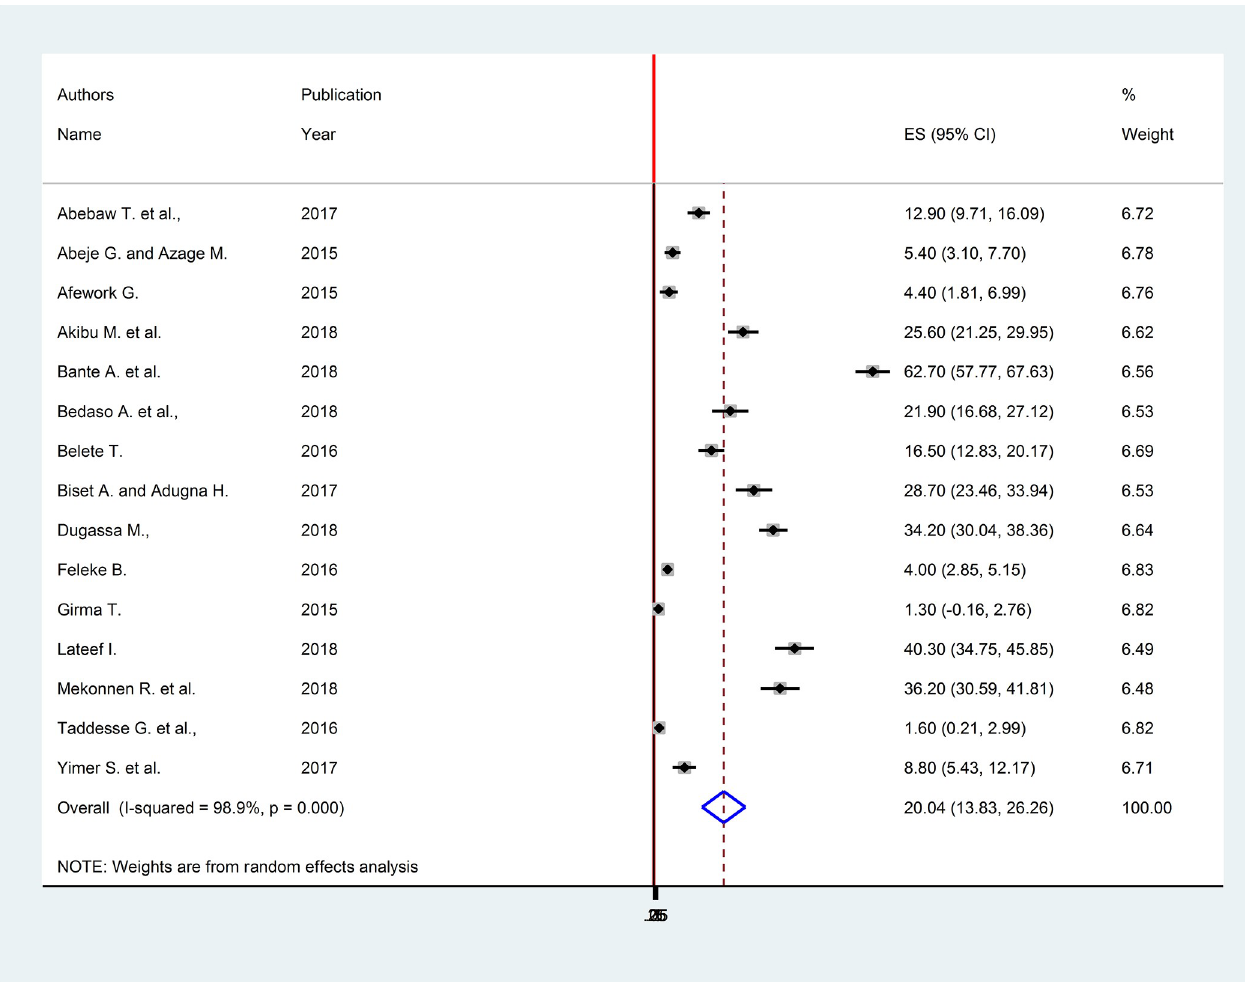
Fig 2. Forest plot showing the pooled prevalence of full-dose hepatitis B vaccination coverage among health care providers in Ethiopia.